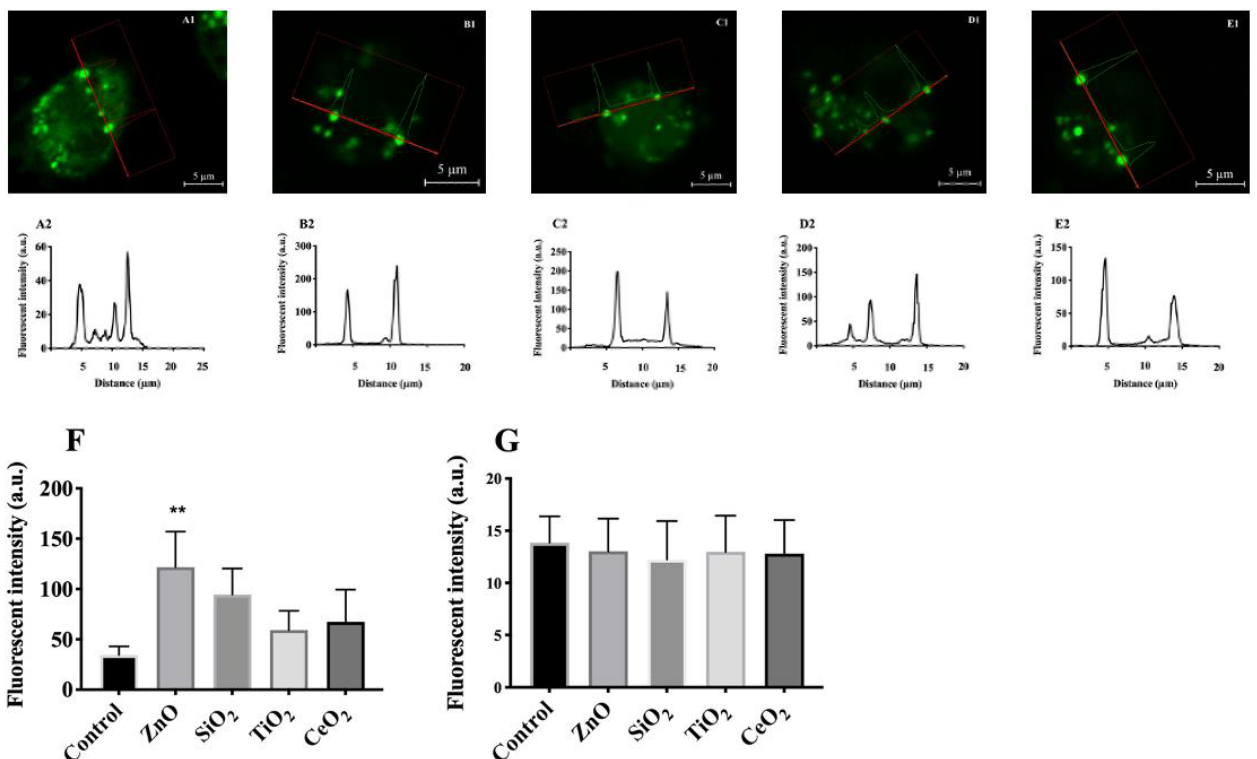
Figure 3. Comparison of the distribution of DiBAC4(3) in control vs particle-treated AM. Confocal images (A1-E1) and representative examples of fluorescent intensity (A2-E2) of DiBAC4(3) in the lysosomes of live AM. AM were incubated with individual particles for 1 h at 37 ◦ C. ( A1 , A2 ) control, ( B1 , B2 ) treated with 100 µ g/mL ZnO, ( C1 , C2 ) treated with 100 µ g/mL SiO 2 , ( D1 , D2 ) treated with 100 µ g/mL TiO 2 and ( E1 , E2 ) treated with 100 µ g/mL CeO 2 . ( F ) Distribution of DiBAC4(3) in the lysosome of control vs treated cells analyzed by one-way ANOVA. ( G ) Distribution of DiBAC4(3) in the cytosol of control vs treated cells analyzed by one-way ANOVA. The fluorescence intensity of at least 100 cells per group was measured and analyzed using ZEN Black imaging software (ZEISS) and ImageJ. Data are presented as means ± SEM of triplicate measurements. ** Indicates significant effect ( p ≤ 0.01) by Holm–Sidak’s multiple comparison test.